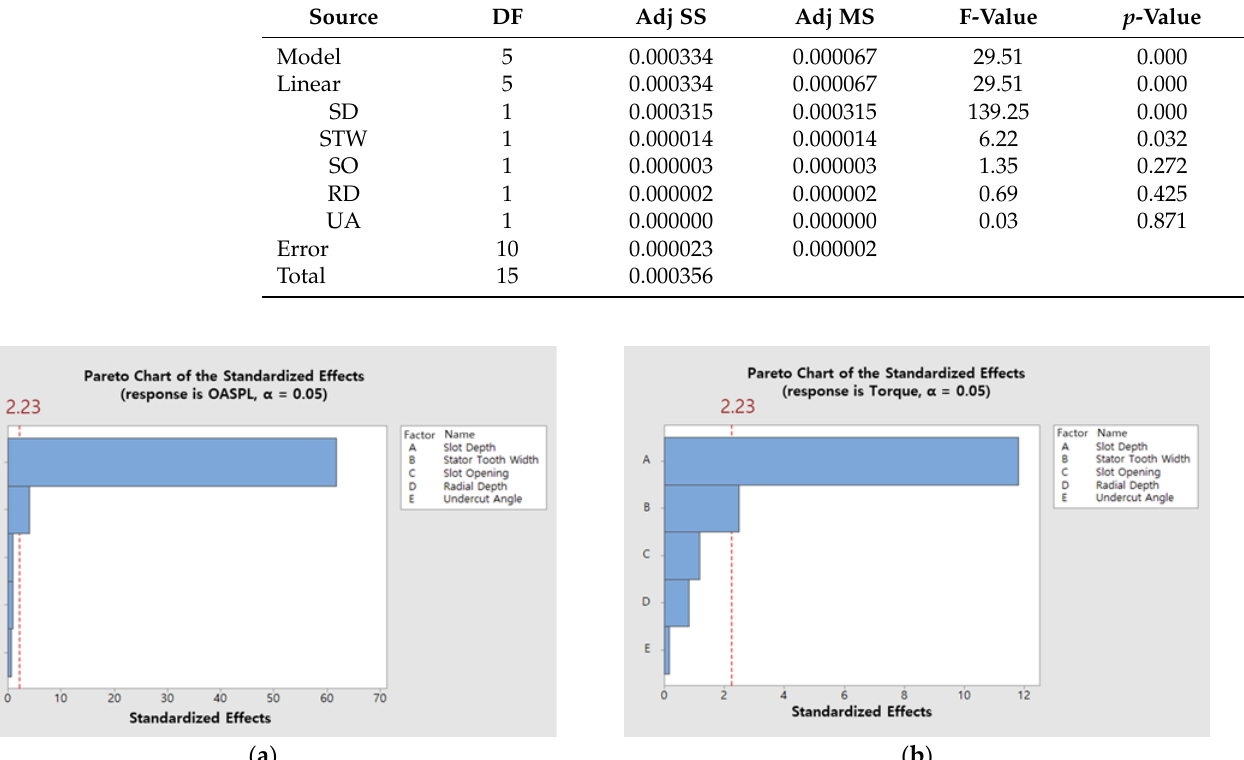
Figure 12. Result of fractional factorial design: ( a ) Pareto chart of the standardized effects of the OASPL; ( b ) Pareto chart of the standardized effects of the torque.